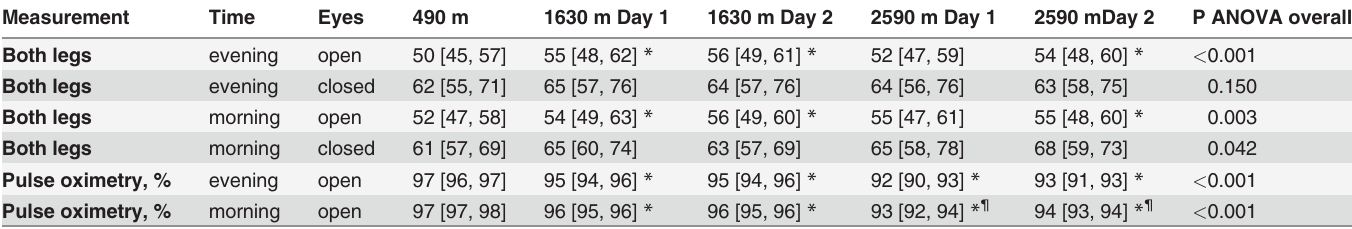
Table 2. Center of pressure path length at different altitudes. Measurement